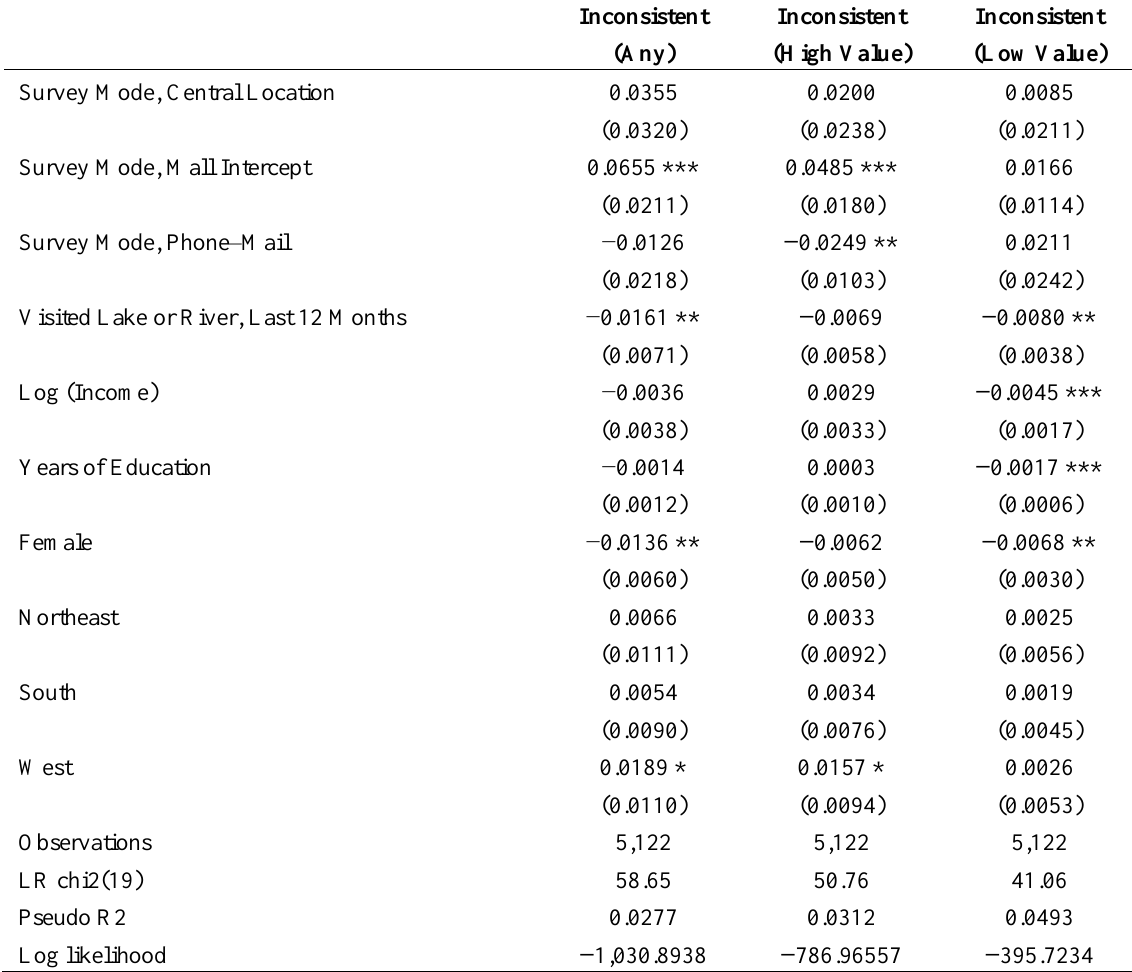
Table 6. Probit regressions predicting inconsistency using demographic characteristics a